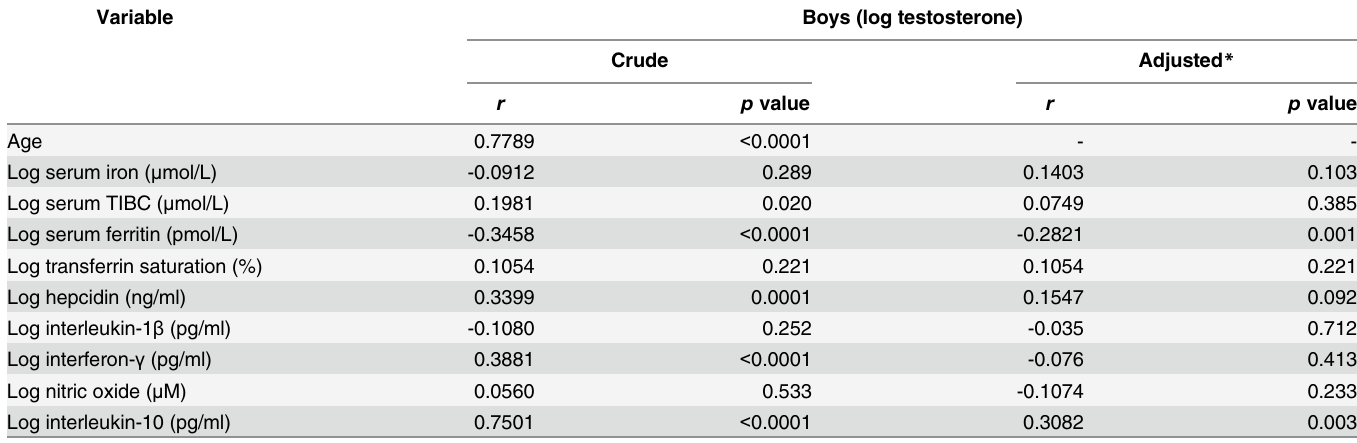
Table 4. Pearson ’ s rank correlation coefficient and partial r of log-transformed serum testosterone with selected iron statuses and inflammatory cytokines in 137